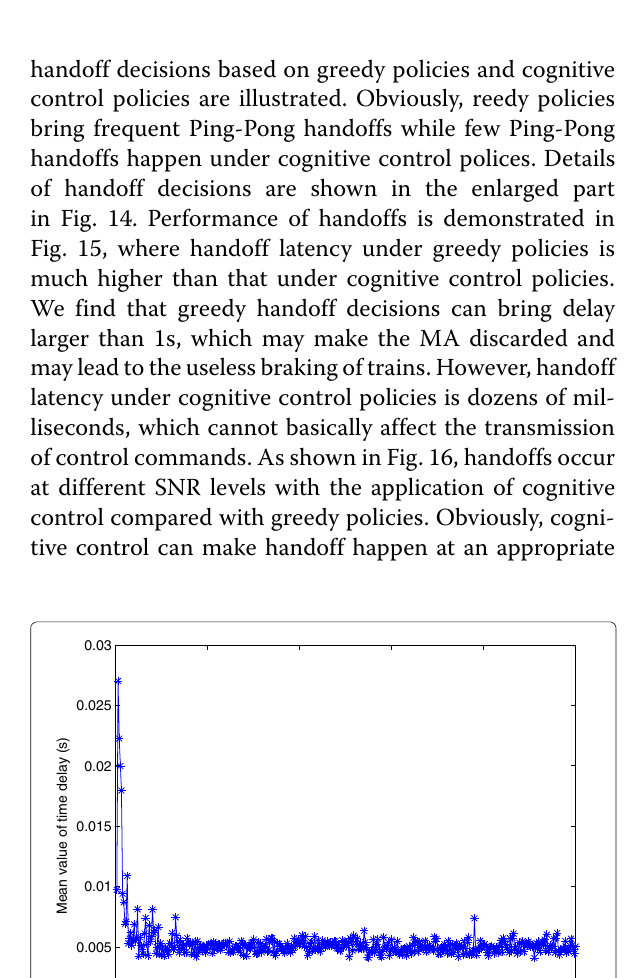
Fig. 10 Convergence of the Q learning algorithm